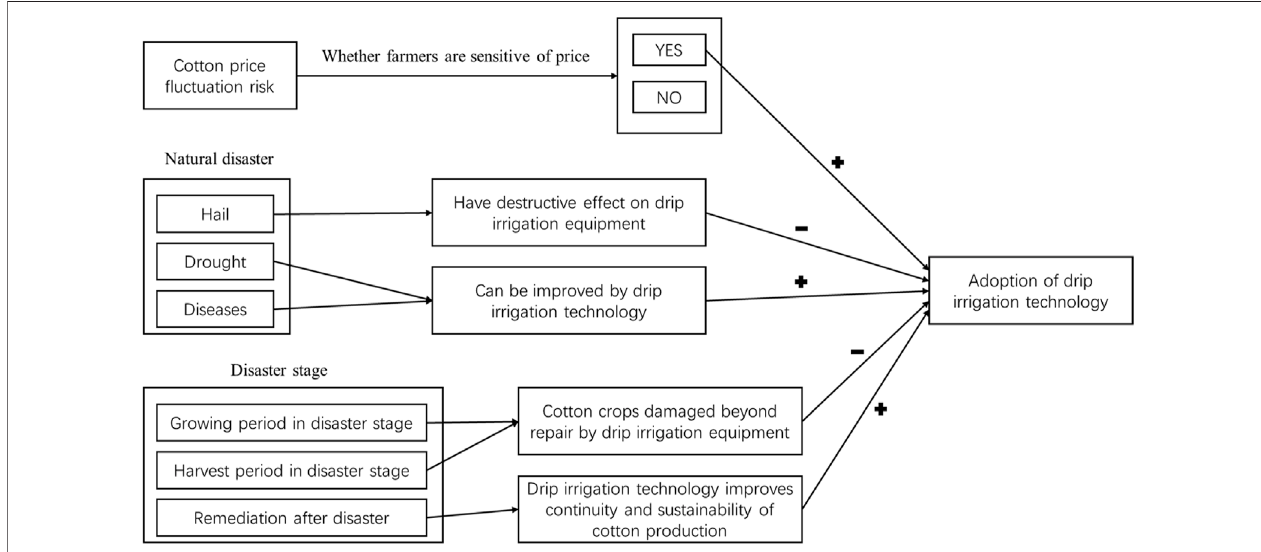
FIGURE 1 | In fl uence mechanism analysis. “ + ” stands for positive effects, “ − ” for negative effects.